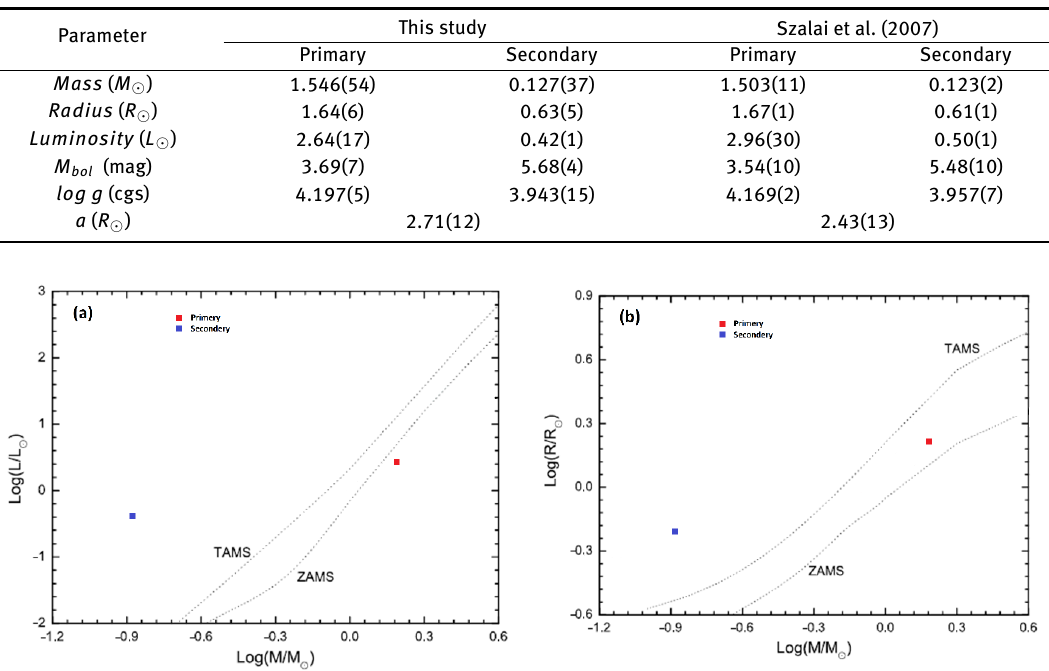
Fig. 6. The logM − logR , and logM − logL diagrams for V870 Ara from the absolute parameters.